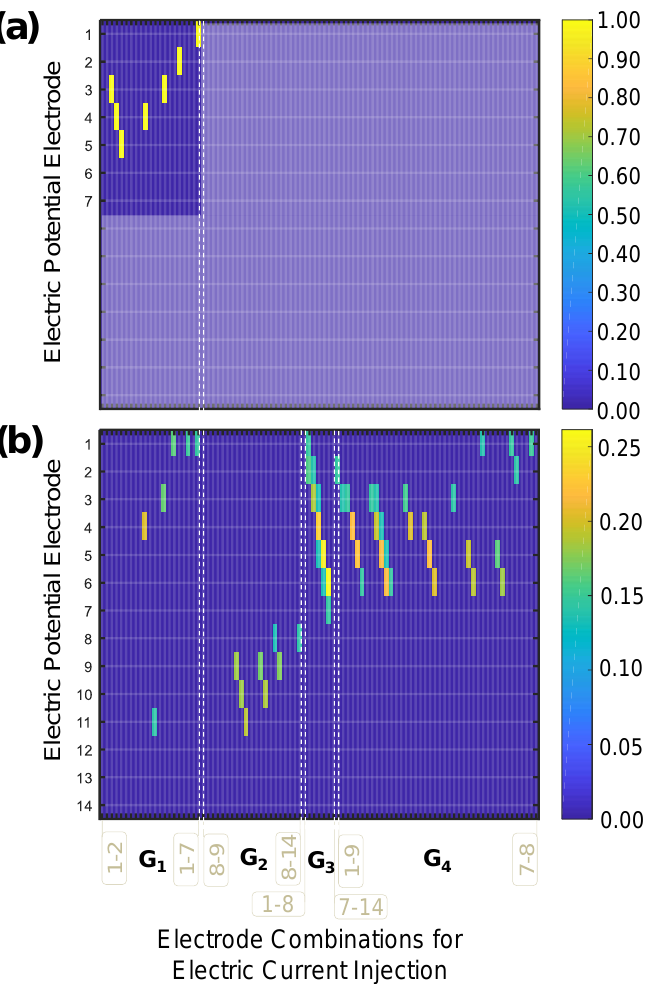
Electrode Combinations for Electric Current Injection Figure 8. Results of Effective Independence on multi-probe schemes [( 0/90 ) 4 ] s layup using ( a ) one-sided electrodes and ( b ) two-sided electrodes. Electrode combination reduction on the multi-probe schemes using one-sided electrodes retains seven out of 126 combinations for the [( 0/90 ) 4 ] s laminate, and six out of 126 combinations for the [ 0 ] s laminate are retained using one-sided electrodes. For both layups, the retained combinations 4 /90 4 were those in which electric potential is measured at the electrode where electric current is injected, which is equivalent to a direct resistance measurement (as in a two-probe